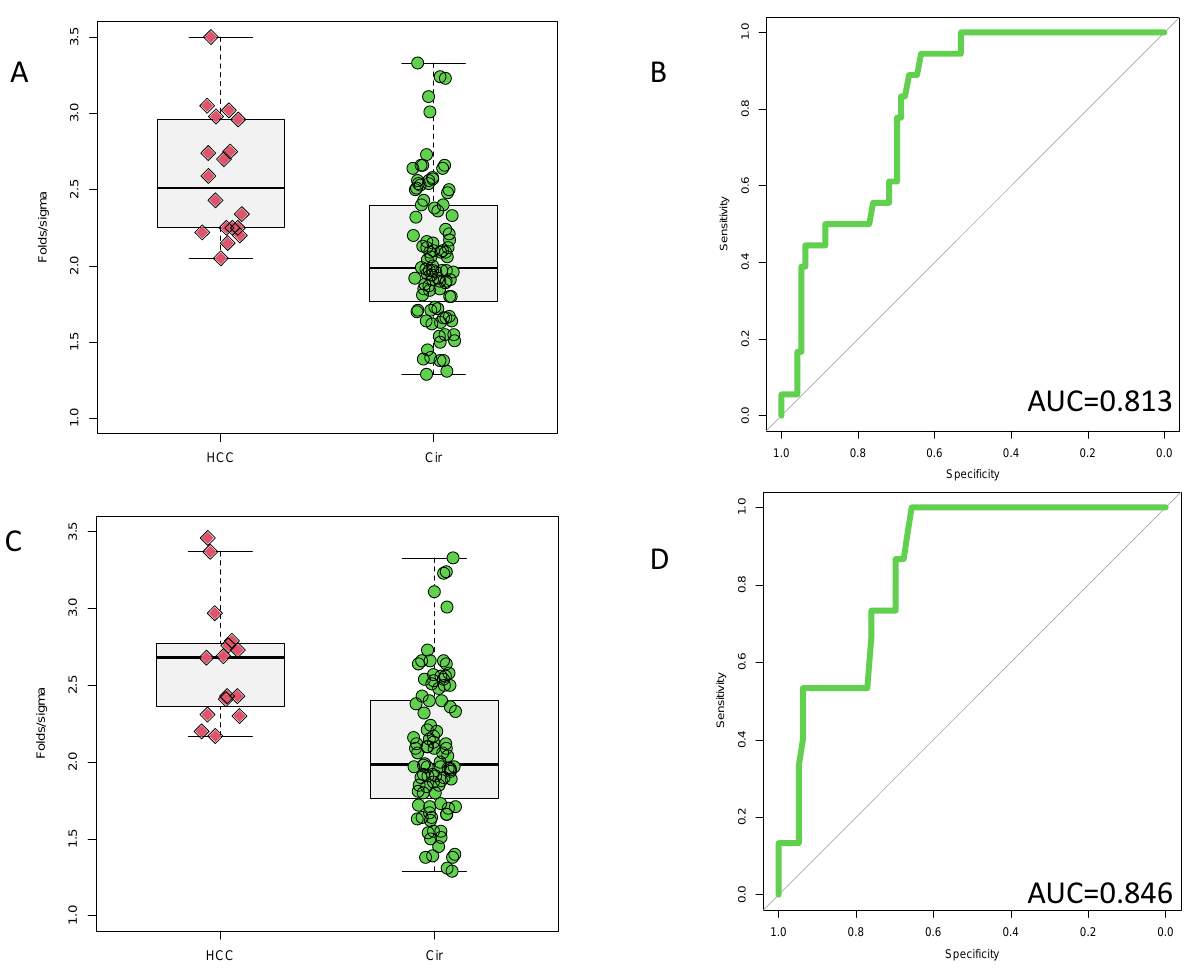
Figure 3. Validation of PEG-IgG in samples collected prospectively but analyzed blinded in a retrospective manner. ( A ) Box and whiskers plot of PEG-IgG in either cirrhotic patients who did not develop HCC or in patients who developed HCC 1–6 months later. ( B ) AUROC of PEG-IgG from cohort shown in panel ( A ), which has a value of 0.813. ( C ) Box and whiskers plot of PEG-IgG in either cirrhotic patients who did not develop HCC or in patients who developed HCC 7+ months later. ( D ) AUROC of PEG-IgG from cohort shown in panel ( A ), which has a value of 0.846.